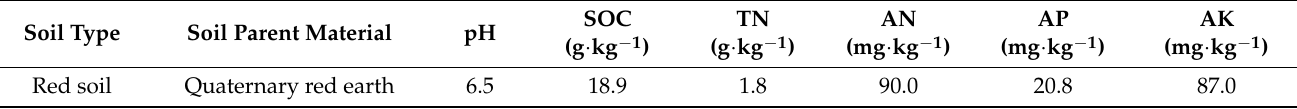
Table 1. Initial physical and chemical properties of the 0–20 cm